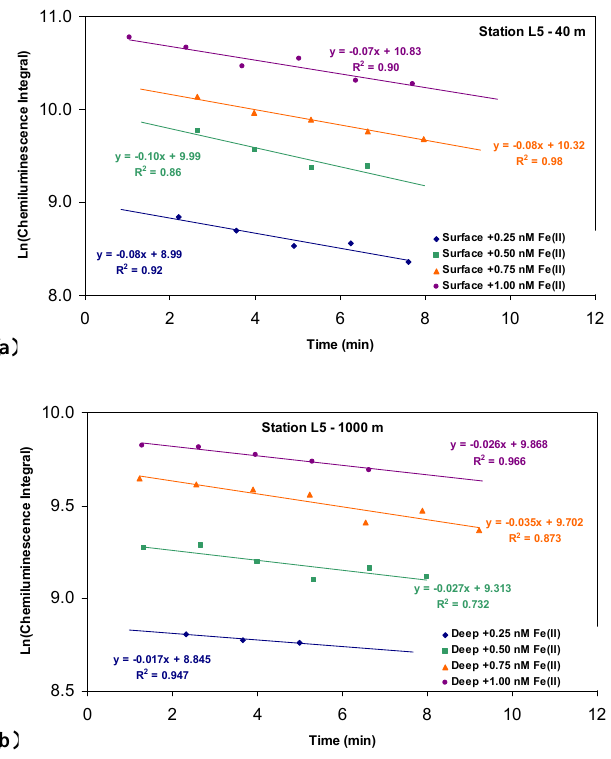
Fig. 4. Natural logarithm transformation of the chemiluminescent integral vs. time for Fe(II) spikes (0.25–1nM) in a surface sample (a) and a deep one (b) . See text for more details.